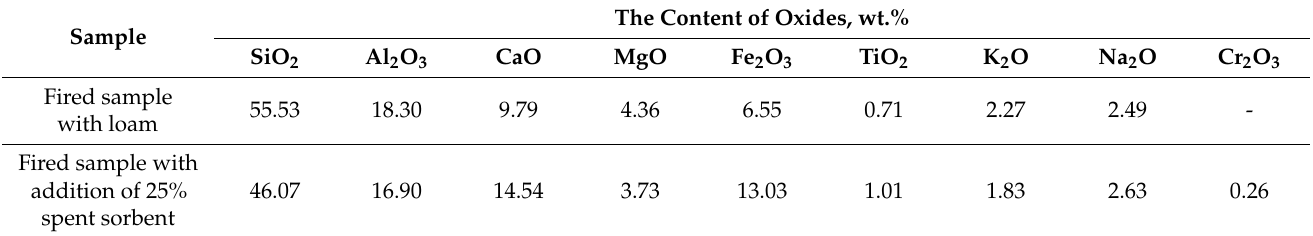
Table 9. Average chemical composition of the fired